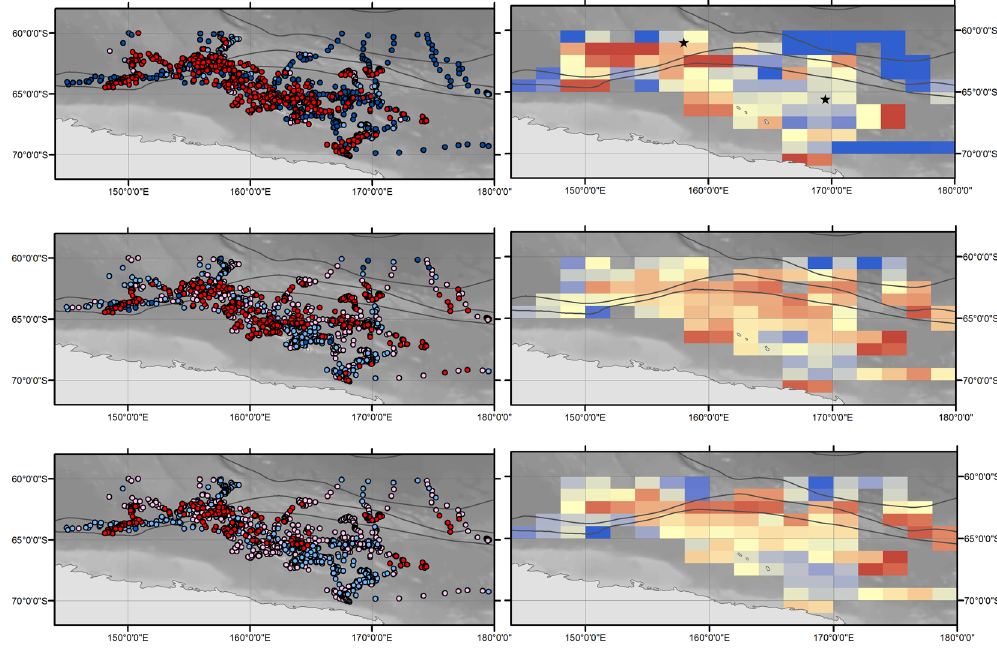
Figure 4. Maps showing whale behavioural state estimates. ( a ) Behavioural state estimates from the hierarchical state-space switching model. Panel focusses on the area of most concentrated search behaviour between 145–175 °E. Predicted probabilities of being in search behaviour obtained from ( b ) the GAMM using environmental predictors, and ( c ) averaging the GAMM predictions (n = 100) across the resampling procedure (see Methods). Colours represent the gradient from transit (P < 0.25, dark blue) through to search (P > 0.75, red) at 0.25 intervals. Right hand panels: ( d , e and f ) spatially aggregate these probabilities into 1° latitude × 2° longitude grid cells by averaging across individual whales. Higher mean probabilities of search behaviour shown as warmer colours. The star symbols in ( d ) represent areas of persistent use between tracking years. Background shading indicates bathymetry derived from the GEBCO Digital Atlas 103